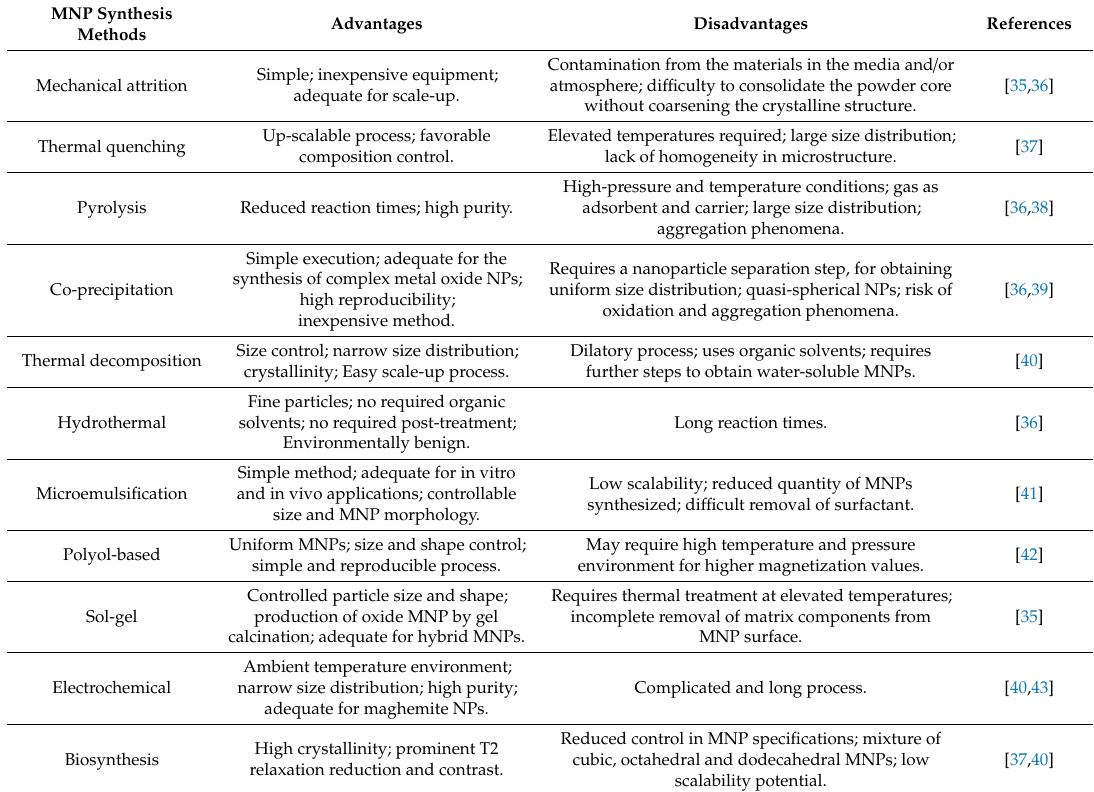
Table 2. Benefits and limitations of the MNP synthesis